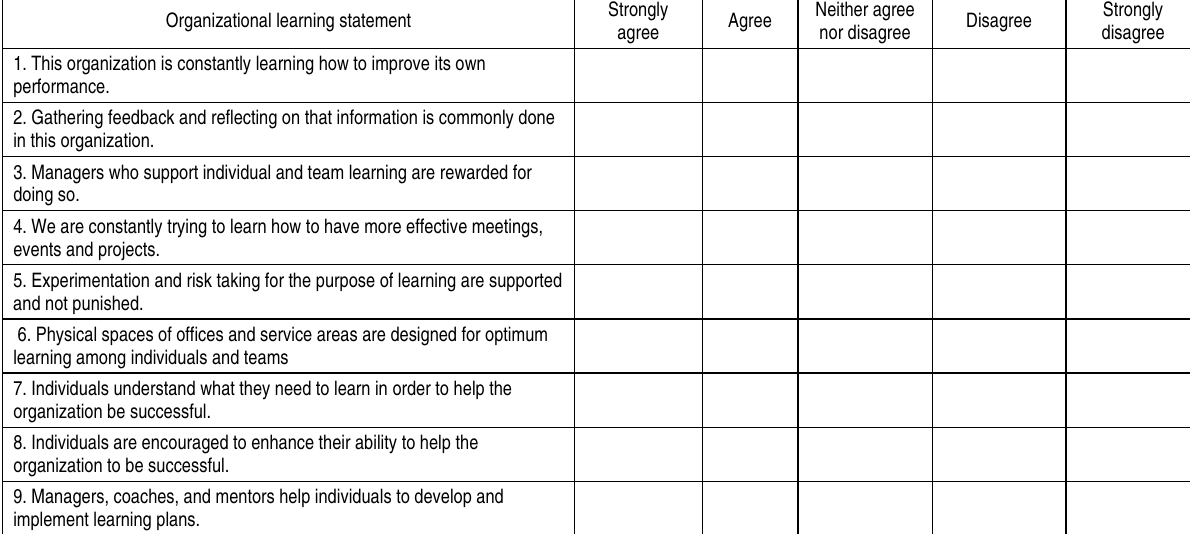
Table 4. Organizational learning